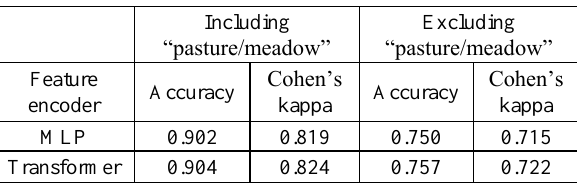
Table 4. Comparison of overall accuracy and Cohen’s kappa obtained on the testing subset with MLP and Transformer feature encoders. Both tests use a Transformer model as decoder. We present results including and excluding the crop class “pasture/meadow” from scores computation.